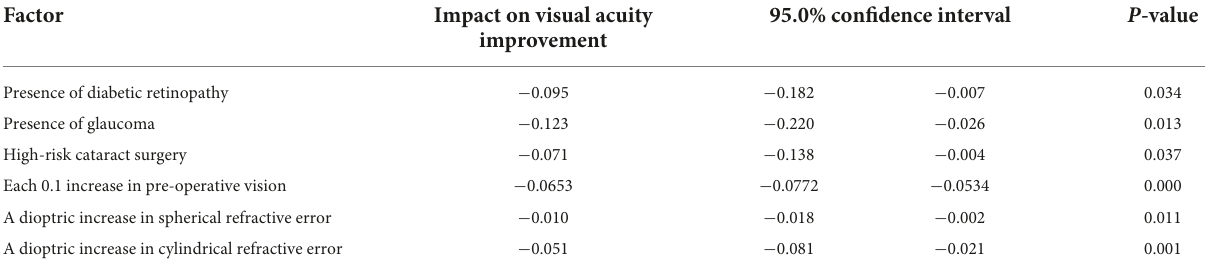
TABLE 2 Predictors of visual acuity